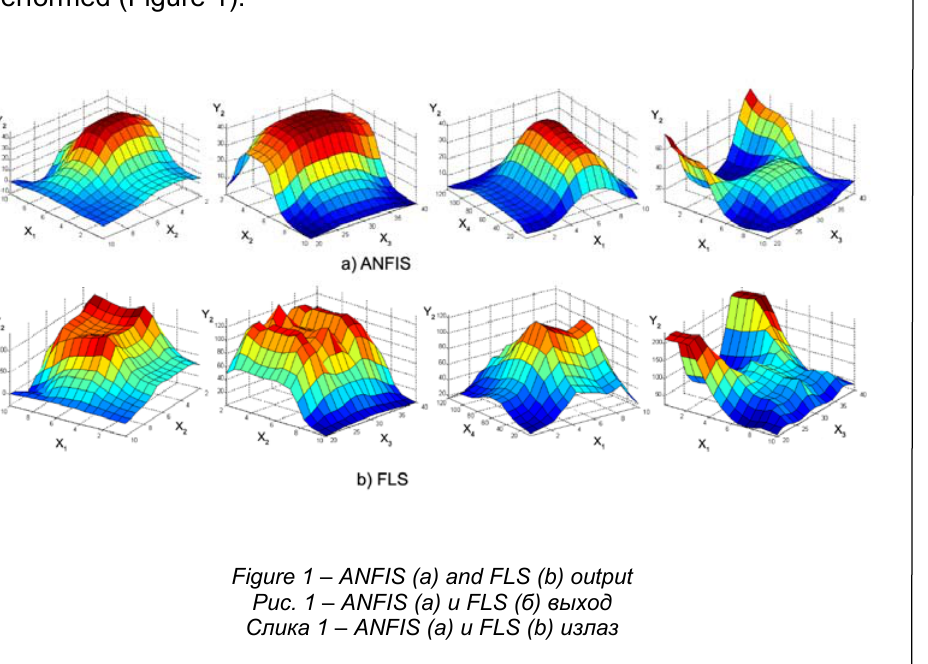
Figure 1 – ANFIS (a) and FLS (b) output Рис . 1 – ANFIS ( а ) и FLS ( б ) выход Слика 1 – ANFIS (a) и FLS (b)